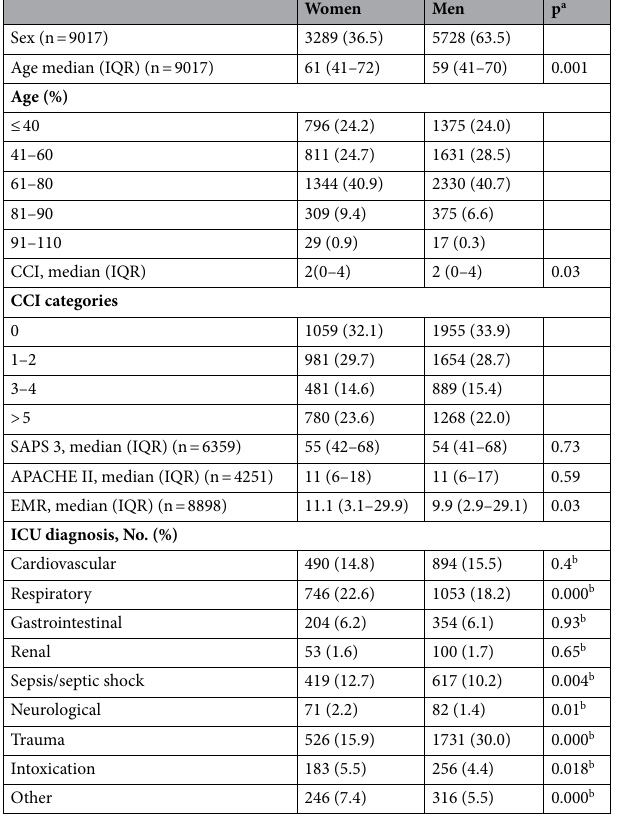
Table 1. Patient characteristics. Continuous parameters presented as median (IQR). Categorical parameters presented as number (%) unless indicated otherwise. CCI Charlson Co-morbidity Index; SAPS 3 Simplified Acute Physiology Score; APACHE II Acute physiology and chronic health evaluation; IQR Interquartile Range; ICU Intensive care unit; EMR Estimated Mortality Risk. a Wilcoxon rank-sum test, b Chi-square